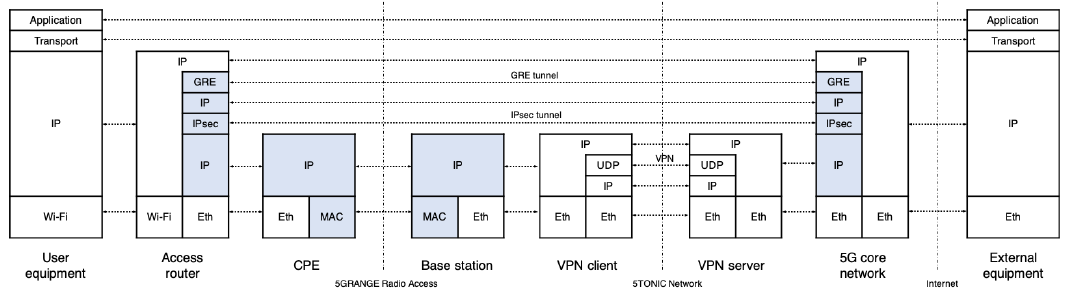
Figure 4. Data-plane protocol stack of the residential